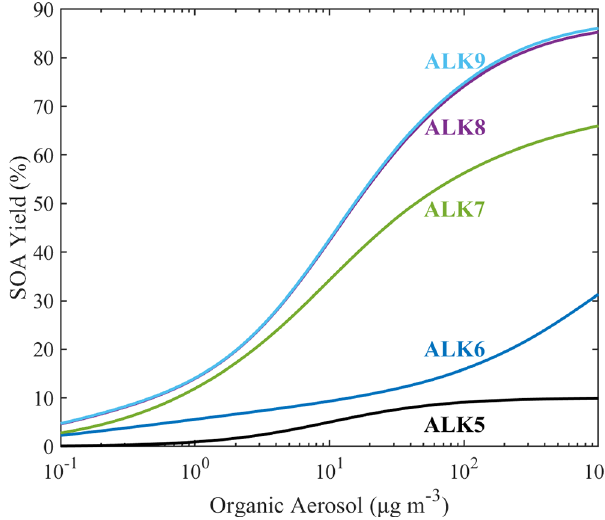
Figure 8. Estimated SOA yields of the new lumped alkane species under high-NO x conditions. The curves are generated using the SOA yield parametrization of Table